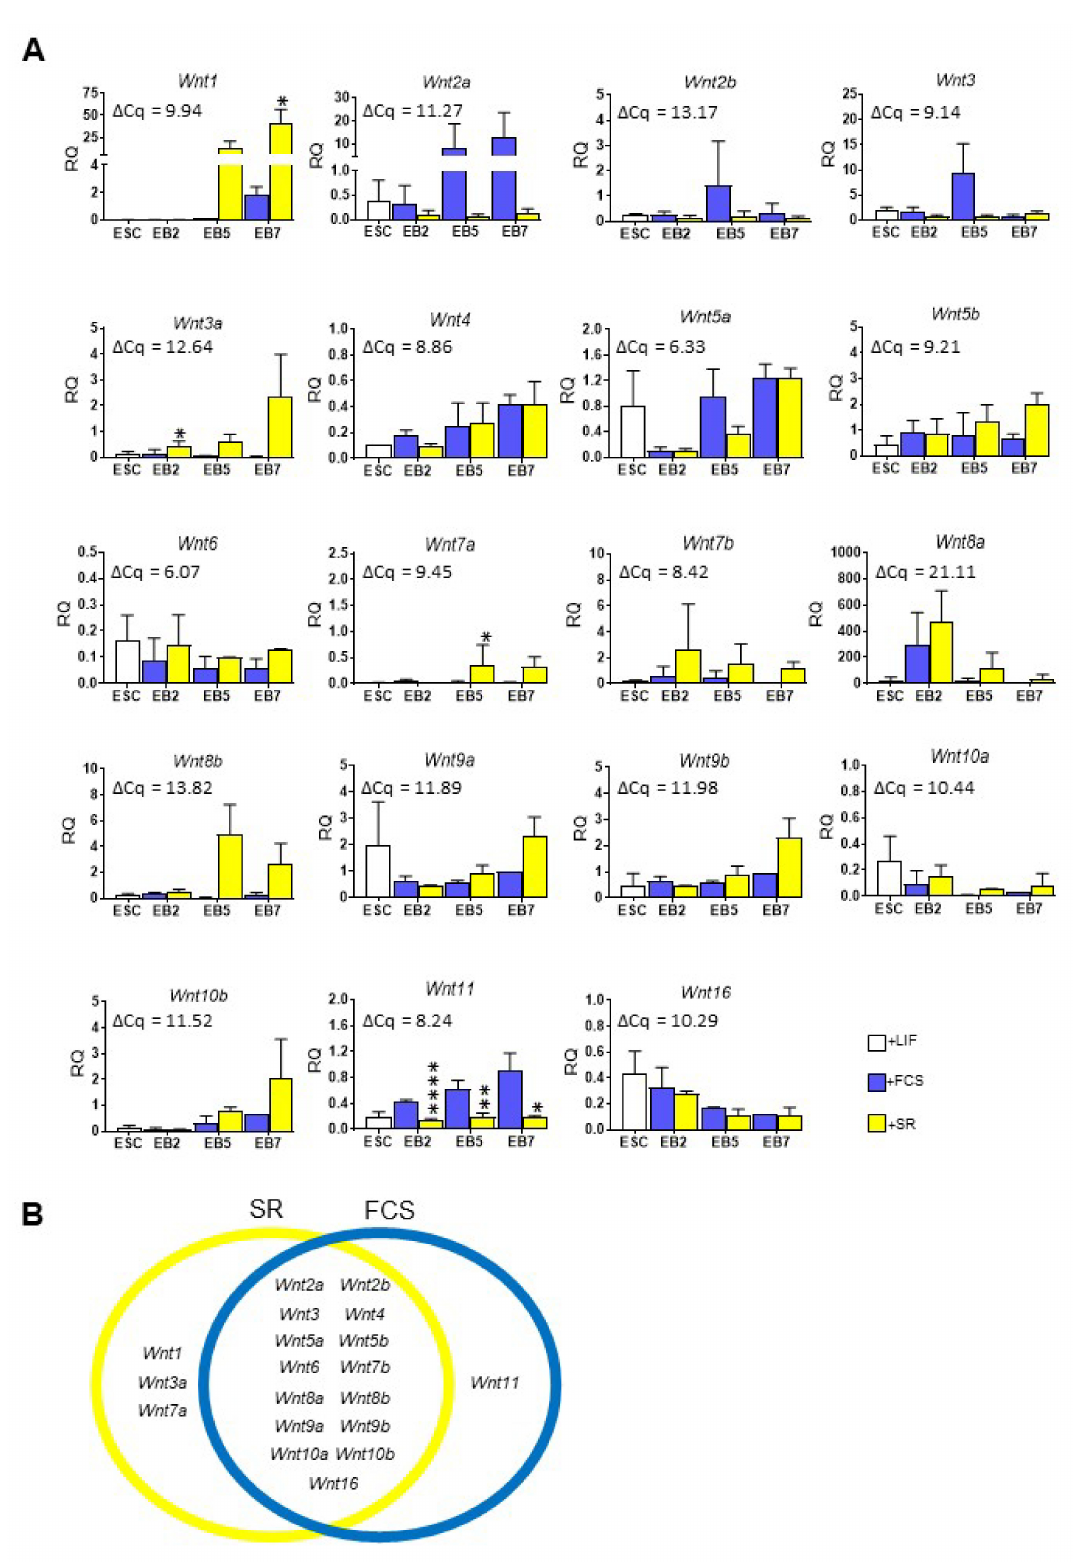
Figure 3. Wnt expression in undifferentiated and differentiating ESCs cultured in medium supplemented either with FCS or SR. ( A ) qPCR analysis. β -actin was used as a reference gene. RQ=1 for the level of gene expression detected in a